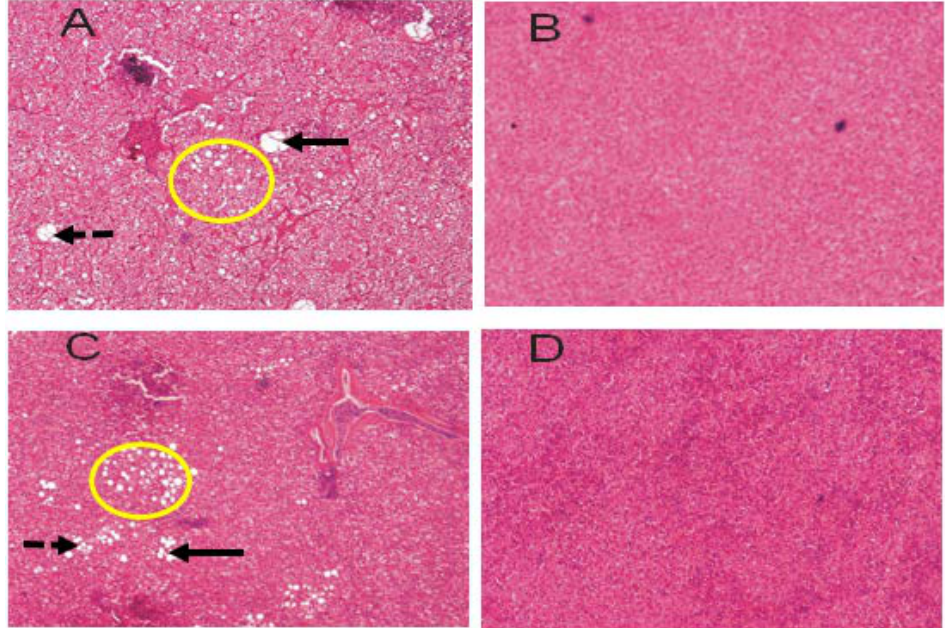
Figure 1. Liver test of non-alcoholic fatty liver (NAFL) and the control. ( A ): Liver of a CORT-fed chicken at week 2 of CORT administration; ( B ): liver of a control chicken at week 2 of CORT administration; ( C ): liver of a CORT-fed chicken at week 4 of CORT administration, and ( D ): liver of a control chicken at week 4 of CORT administration. Liver samples of the chickens exposed to corticosterone (CORT) feeding showed pathological symptoms. ( A , C ) show pathological symptoms (fibrosis, ballooning, inflammation, and steatosis) while ( B,D ) do not. Exposure of chickens to 30 mg/kg CORT diet caused apoptosis and non-alcoholic fatty liver. H&E, 4x. Dark arrows = fibrosis and steatosis; dotted arrows = ballooning; circle = inflammation. Table 7. Scoring and grades of non-alcoholic fatty liver in the CORT-fed chickens versus control chickens. Symptoms/Grades